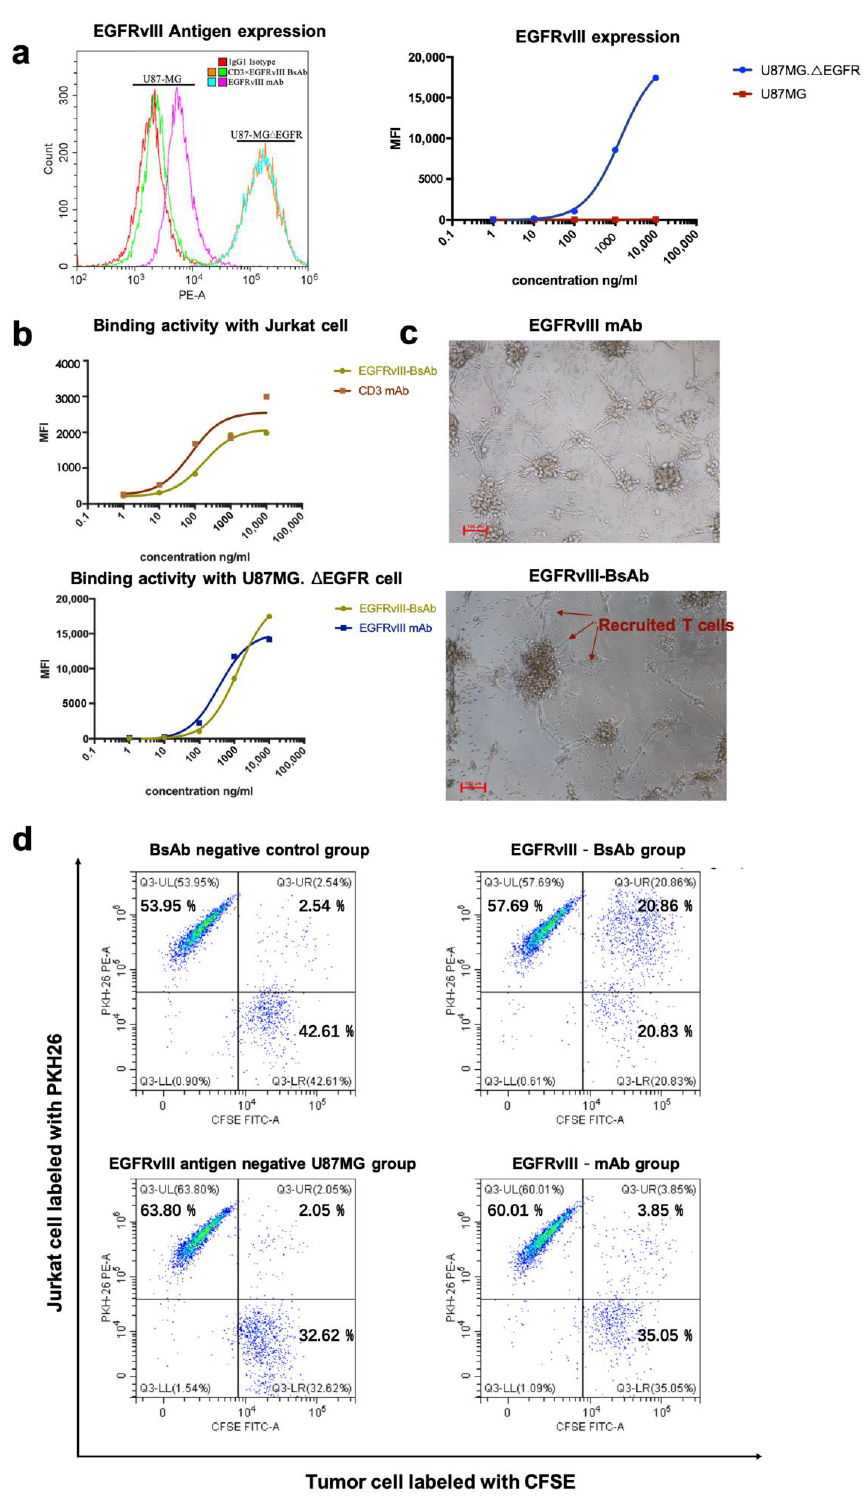
Figure 3. ( a ) EGFRvIII antigen expression level on mutant GBM cell line U87MG. ∆ EGFR and wild-type GBM cell line U87MG. ( b ) A binding activity comparison of EGFRvIII-BsAb and CD3 mAb with Jurkat cells (CD3-positive) (upper), as well as a binding activity comparison of the EGFRvIII-BsAb and the EGFRvIII mAb with U87MG. ∆ EGFR cells (EGFRvIII- positive) (lower). ( c ) Photographs of the redirection of T cells to cancer cells by 0.01 ng/mL EGFRvIII-BsAb or EGFRvIII mAb. ( d ) FACS analysis of the redirection of CD3+ Jurkat cells to cancer cells by EGFRvIII-BsAb. Jurkat (CD3+) cells labeled by PKH26 (PE-A), as well as U87MG. ∆ EGFR cells labeled by CFSE